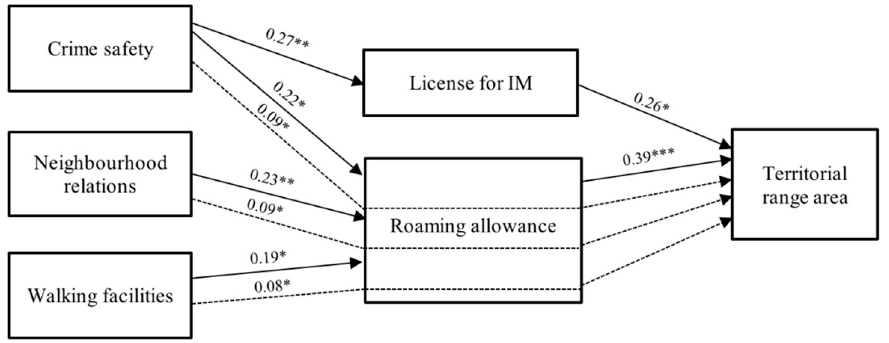
Figure 2. Summary of pathways for significant direct and indirect effects for territorial range area. All path coefficients were standardized. Solid lines indicate direct effects, dashed lines indicate indirect e ff ects. * p < 0.05, ** p < 0.01, *** p < 0.001; IM: independent mobility.